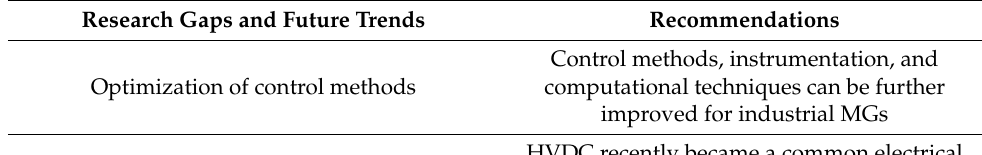
Table 4. Research gaps and future trends of industrial MGs (source: own